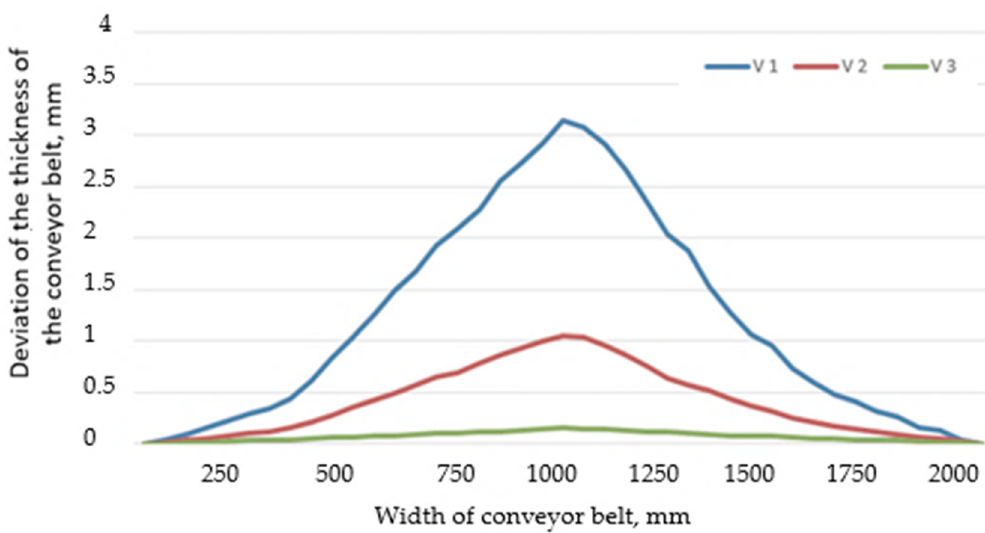
Figure 17. Evolution of the thickness on width deviation for the combined conveyor belts using the three constructive variants of the belt vulcanization press.